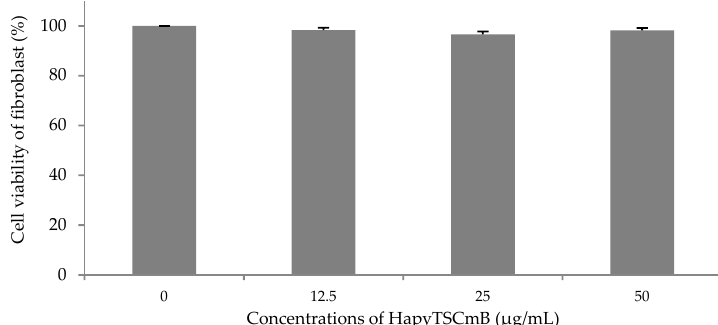
Figure 8. Cell viability of fibroplast cell incubated with increasing amounts of HapyTSCmB.